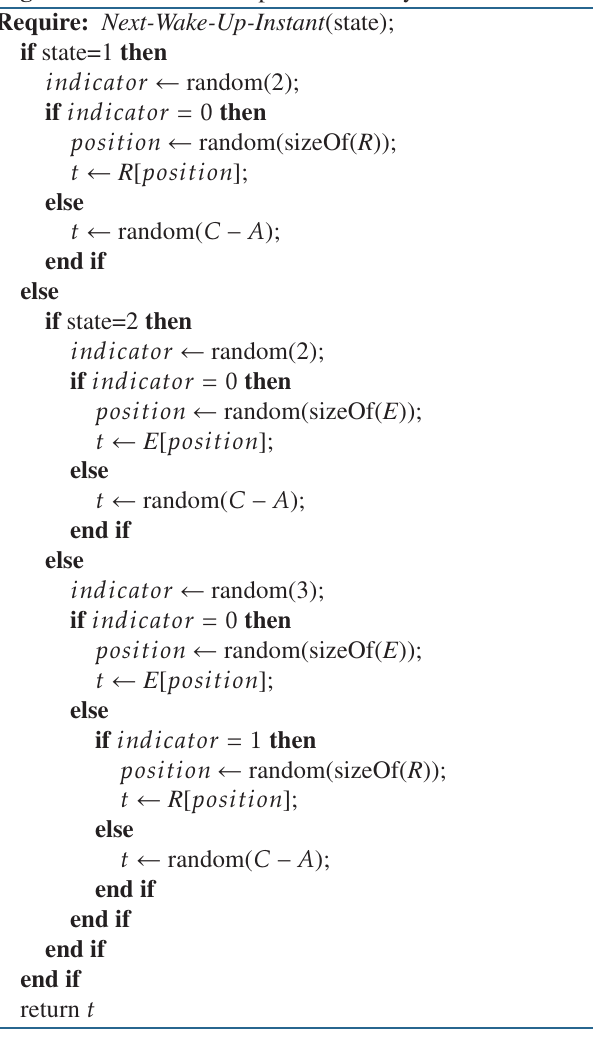
Algorithm 2 Next wake-up instant in a cycle i .